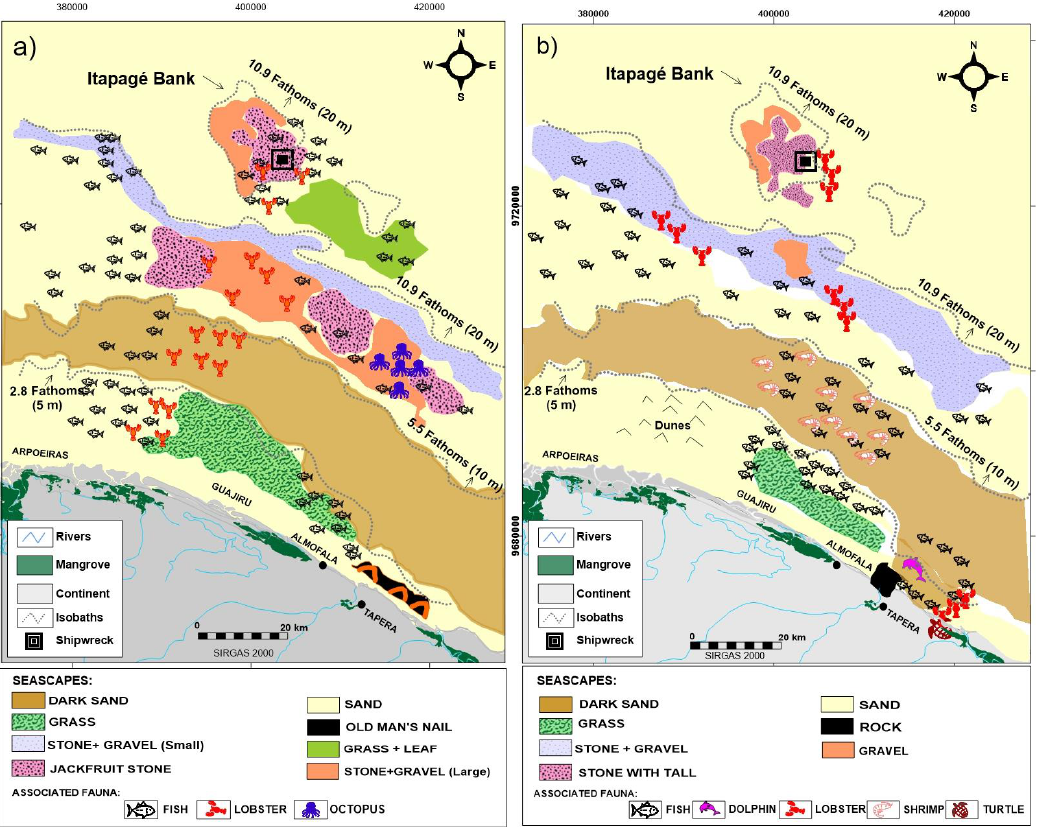
Figure 3. Seascape ethnomap at ( a ) Almofala and ( b ) Tapera fish community and places of occurrence of the main marine organisms. Maps a and b had the participation of 13 and 17 indigenous fishermen, respectively.